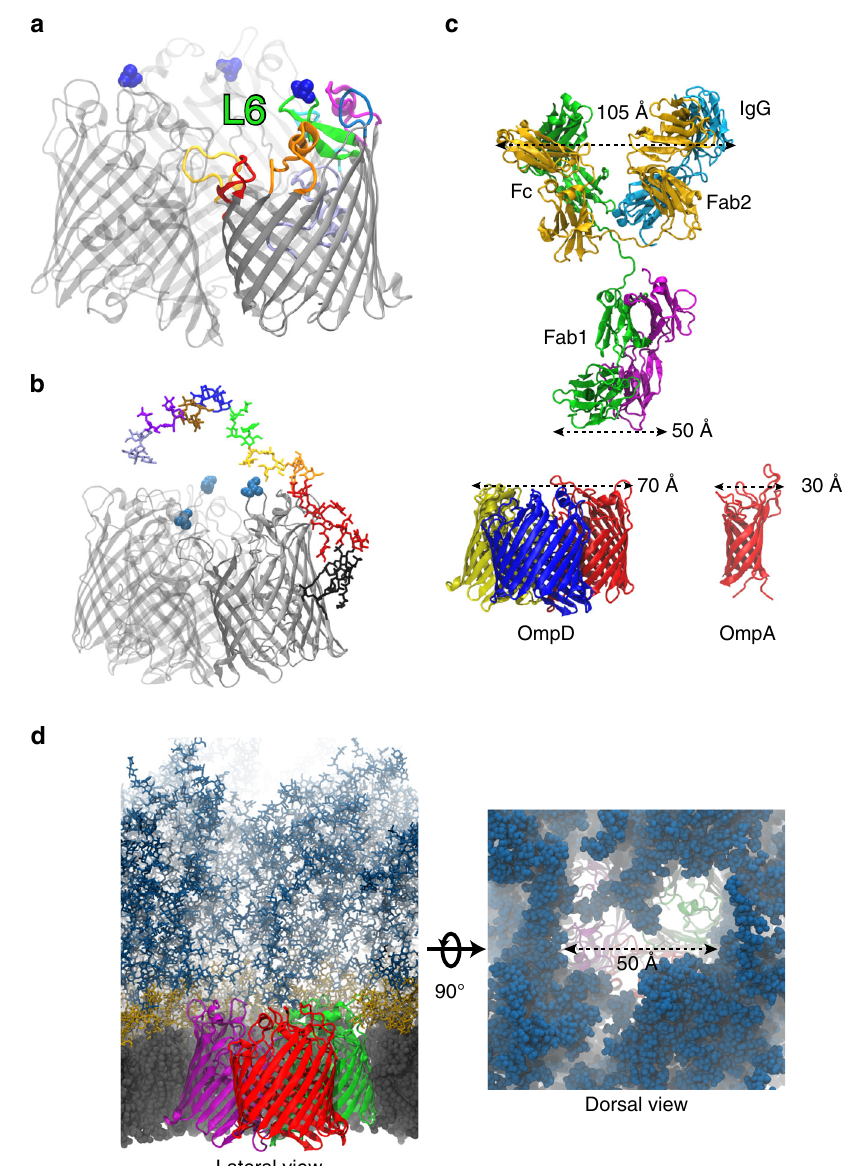
Fig. 4 Acessibility of OmpD epitopes is determined by the LPS component. OmpD structure and the location of the A263S polymorphism in the context of interaction with the LPS layer. a OmpD trimer (homology model) with the location of the A263S variation (blue space fi ll representation) on the tip of the extracellular loop 6 (labeled L6, green in protomer 1). The other extracellular loops in this protomer are shown in different colors consistent with their representation in Supplementary Figs. S2 and S6. b Snapshot of the full atomistic MD simulation of the outer membrane showing an isolated OmpD trimer with a single LPS molecule. LPS elements are colored as follows: Lipid A — black; core sugars in red; O-Ag repeats in rainbow colors. c Size comparison of a murine IgG1 molecule (based on PDB 1IGY) to the OmpD trimer and OmpA. Top shows an IgG1 molecule. The heavy chains are colored in green and gold, while the light chains are in cyan and purple, respectively. Dimensions of various parts are indicated in Å. Bottom left, an OmpD trimer (protomers shown in yellow, blue, and red) and bottom right an OmpA monomer (red). d A wider context of the MD system is shown from the membrane plane (left) and from the top (right). OmpD protomers are colored in purple, red, and green, and LPS elements are colored as follows: Lipid A and inner lea fl et in gray, core sugars in gold, and O-Ag in dark blue. The dense network provided by the LPS O-Ag prevents access to the surface epitopes on OmpD, which is especially clear on the space fi lling top-view representation on the right, showing a typical access channel dimension of 50